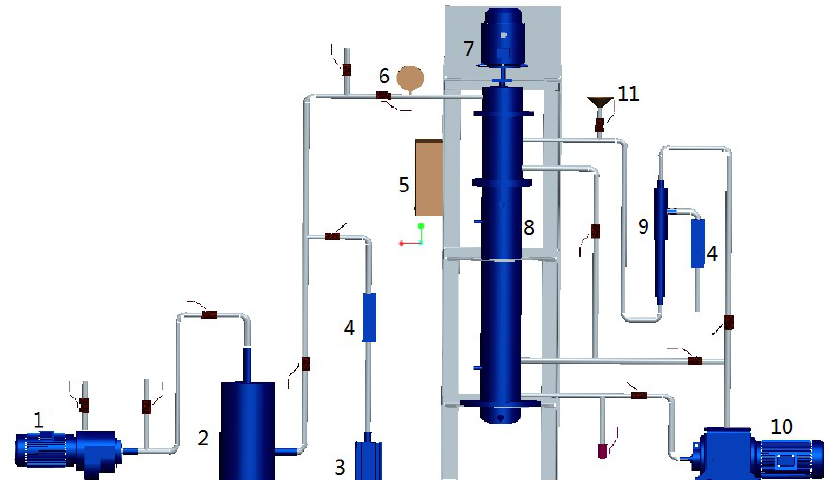
Figure 3. Schematic diagram of the vacuum mechanical defoaming system. 1. Vacuum pump; 2. Steam water separator; 3. Vacuum pump; 4. Gas flowmeter; 5. Electric control panel; 6. Vacuum pressure gauge; 7. Motor; 8. Defoamer; 9. Bubble generator; 10. Pump; 11.